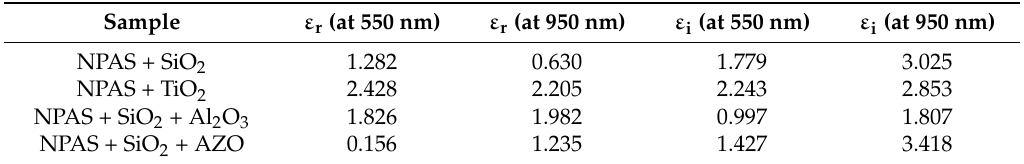
Table 5. Real ( ε r ) and imaginary ( ε i ) component values of the dielectric constant at the two wavelengths Table 5. Real (ε r ) and imaginary (ε i ) component values of the dielectric constant at the two of 550 and 950 nm for the studied nanoporous alumina based wavelengths of 550 and 950 nm for the studied nanoporous alumina based structures.